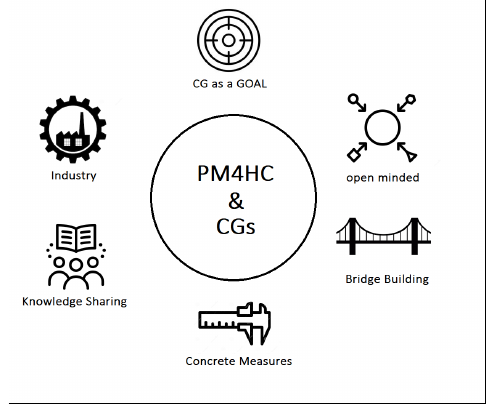
Figure 3. A general overview of some of the most relevant milestones in the modern age of Clinical